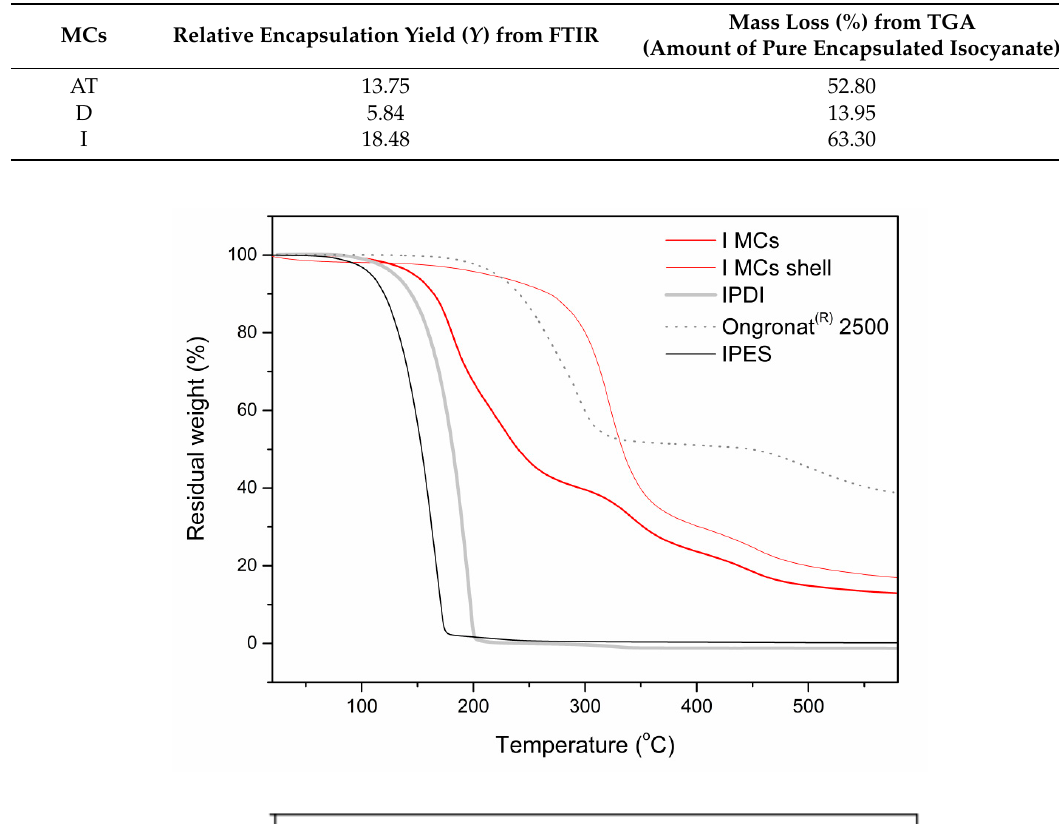
Table 3. Relative encapsulation yield ( Y ) and mass loss (%) of encapsulated IPDI for each synthesis.